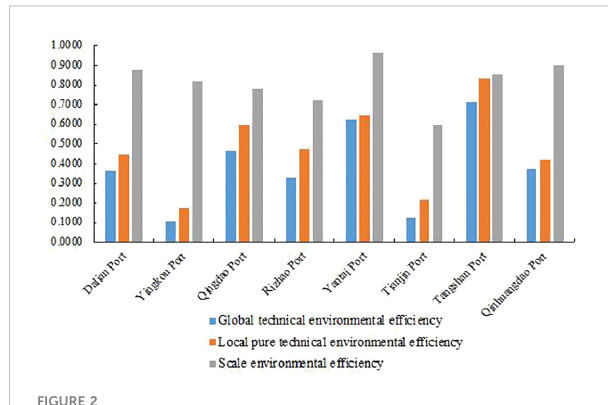
FIGURE 2 The annual average environmental ef fi ciency of the eight